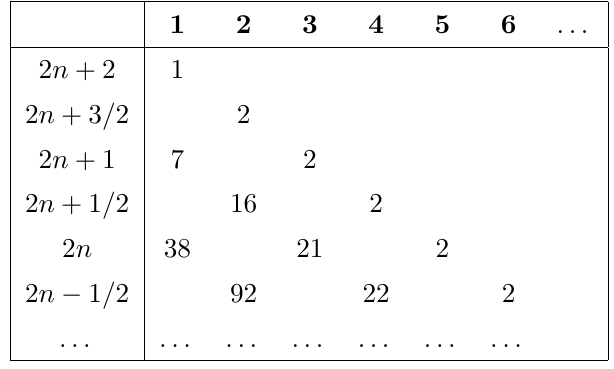
Table 2 . Multiplicities of N = 4 multiplets along the (cid:22) r = 0 edge for j 0 = 0, i.e., m =